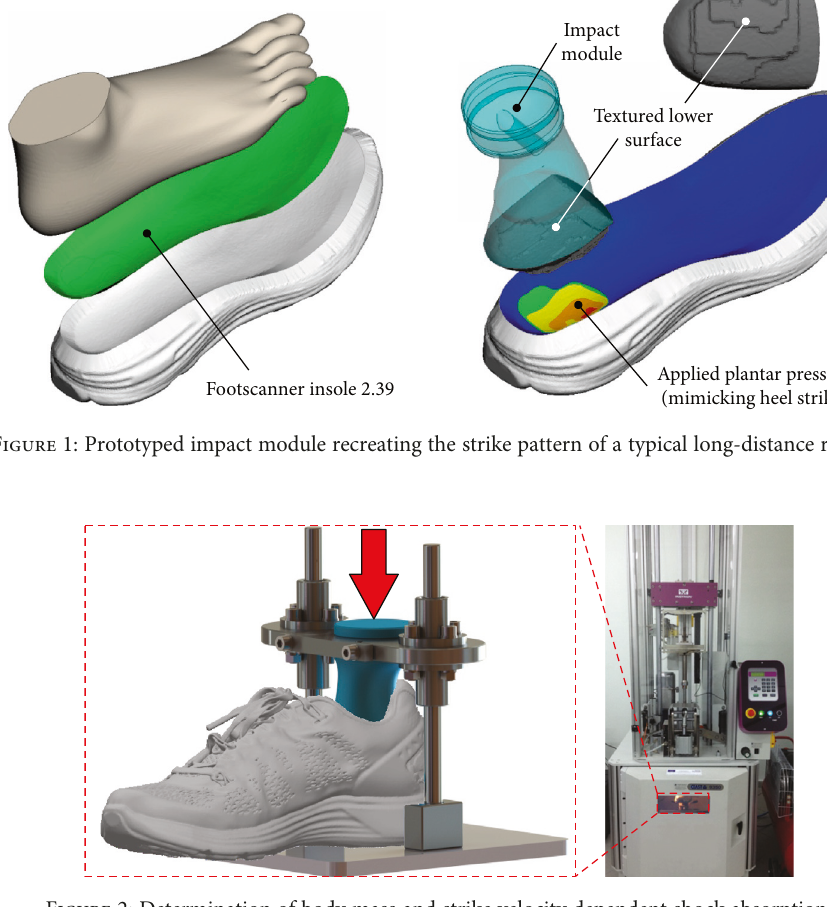
Figure 2: Determination of body mass and strike velocity dependent shock absorption.